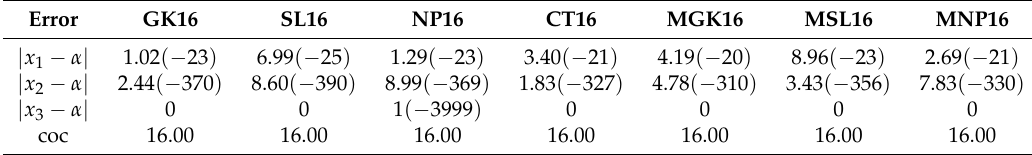
Table 7. Numerical results for f 5 , x 0 = 1.05.